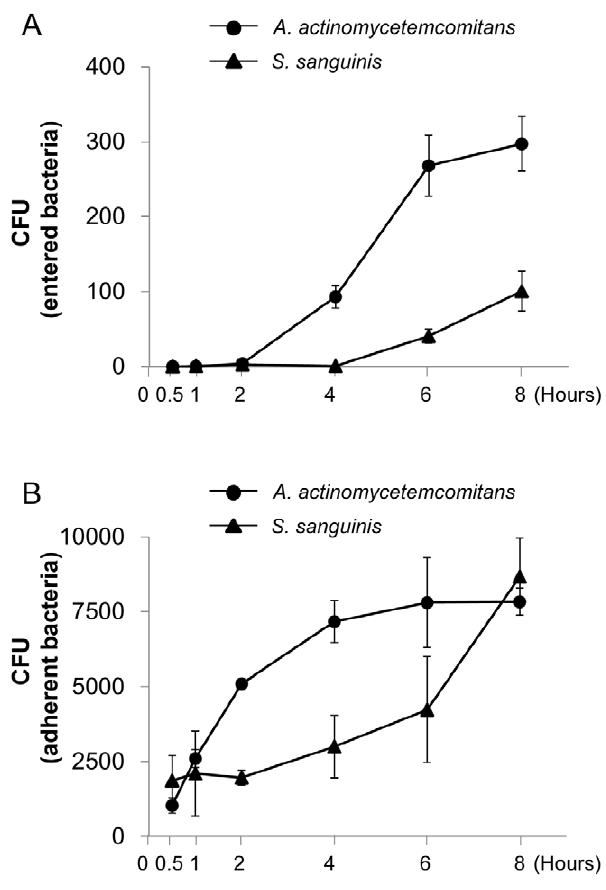
Figure 1. Kinetics of Aa or S.sanguis entry and adhesion to OBA9. (A and B) Aa or S. sanguis growing in middle of logarithmic phase in broth culture was applied to confluent OBA9 cells in 96-well plates (5.5 6 10 5 bacteria/100 m l/well). The multiplicity of infection (MOI) value used in these entry and adhesion assays were about 55 (5.5 6 10 5 bacteria/1.0 6 10 4 epithelial cells/well). The co-culture of bacteria and OBA9 cells was incubated at various times, and bacterial entry and attachment to OBA9 cells were evaluated by the protocol described in Materials and Methods. The number of bacteria which entered (A) or adhered (B) to OBA9 was expressed as a colony forming unit (CFU). Each point represents mean 6 SD of CFU from three wells.